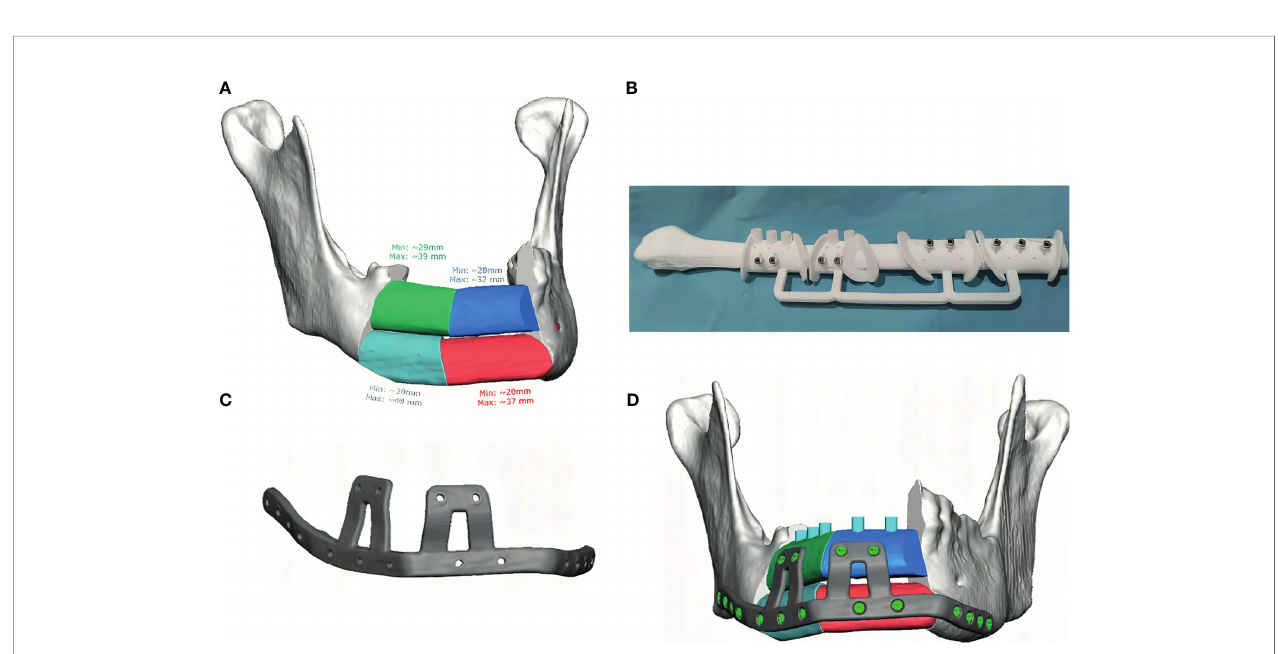
FIGURE 2 | (A) Double-barrel fi bula fl ap designed in four segments for 3D reconstruction of the mandible. (B) Fibula cutting guide including the slots for implant placement. (C) Customized double-barrel titanium plate for rigid fi xation. (D) Final design for mandibular reconstruction including the double-barrel fl ap, the double- barrel titanium plate and the position of dental